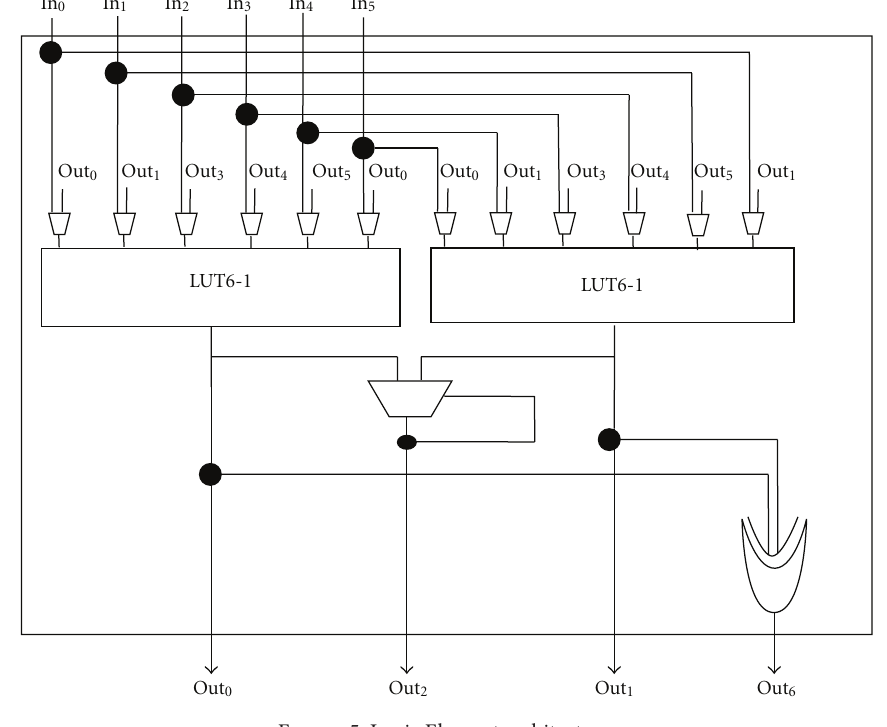
Figure 5: Logic Element architecture.